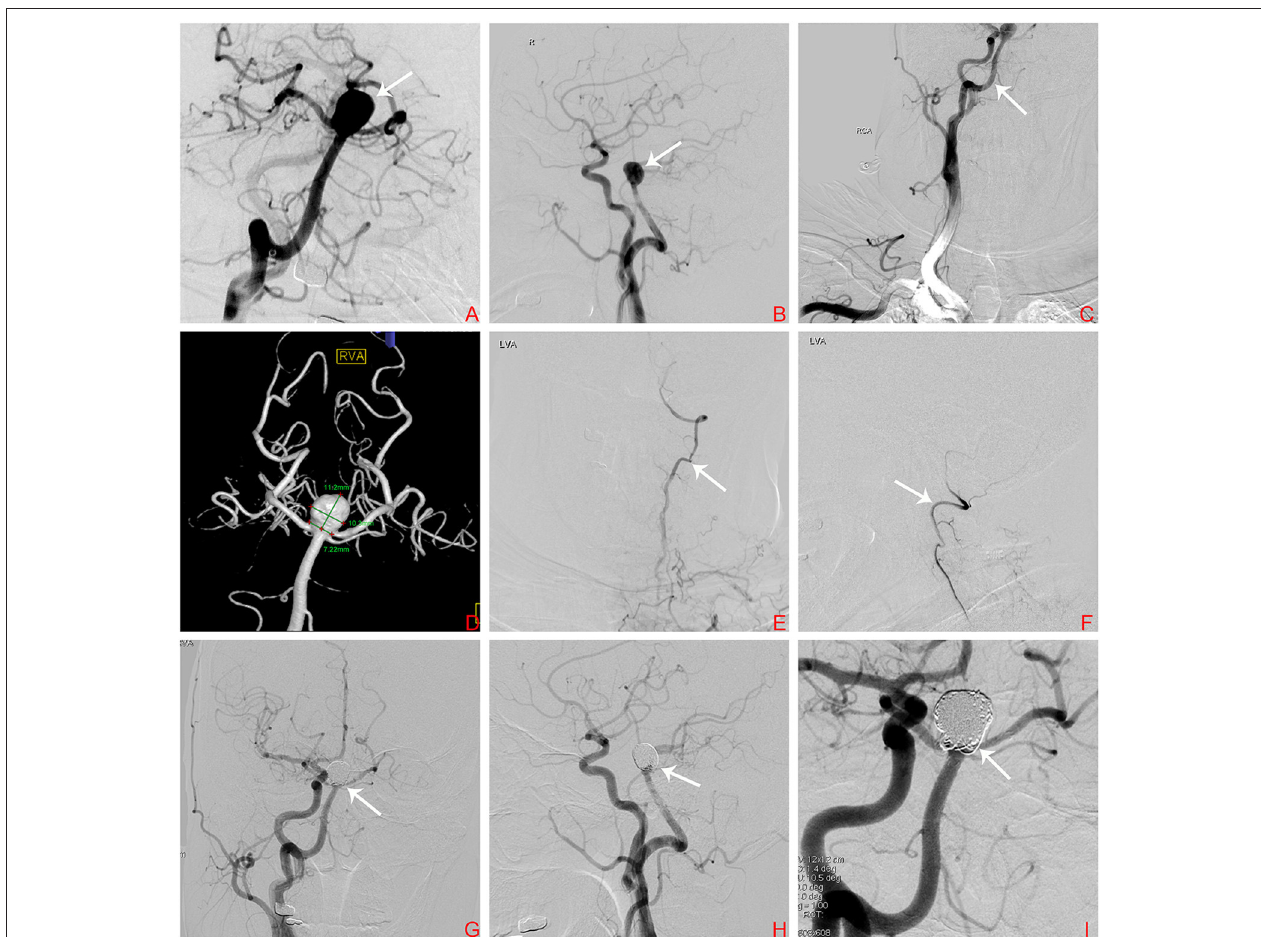
FIGURE 3 | (A) Digital subtraction arteriogram (DSA) of the BA showing a basilar bifurcation aneurysm (white arrow); (B) DSA, lateral view of the right ICA showing a basilar bifurcation aneurysm (white arrow); (C) DSA lateral view of the right ICA showing the PPHA (white arrow) originating from the right ICA at the level of C1–C3; (D) Three-dimensional DSA demonstrating an unruptured basilar bifurcation aneurysm measuring 10.3 × 11.2mm at the dome, with a 7.22-mm-wide neck (dome-to-neck ratio = 1.58); (E,F) DSA lateral views of the left VA showing hypoplasia of the left VA (white arrow); (G–I) Follow-up DSA demonstrating complete embolization of the aneurysm. The white arrow indicates no significant sign of recurrence. BA, basilar artery; ICA, internal carotid artery; PPHA, persistent primitive hypoglossal artery; VA, vertebral